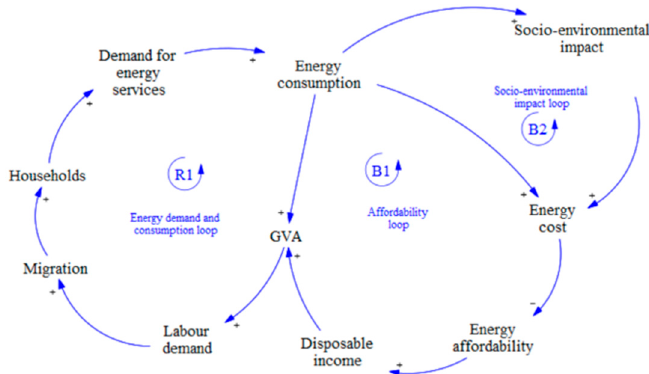
Figure 2. Aggregated dynamic hypothesis of the gendered urban household energy transition. Source: Authors.